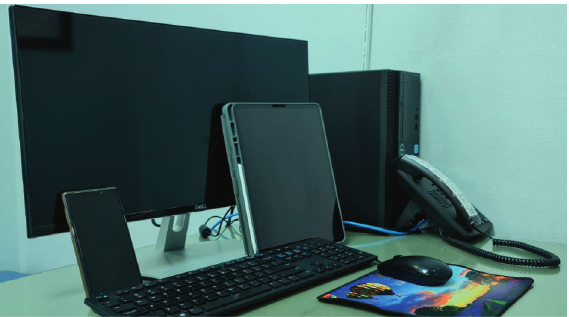
Figure 1: Different screen-based devices used for teledentistry consultations in the ASEAN